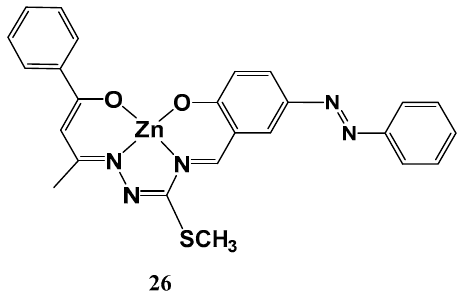
Figure 5. Structure of unsymmetrical Schiff bases of the S ‐ methylisothiosemicarbazide derivative. Unsymmetrical, alkoxy ‐ derivatized Schiff ‐ base Zn(II) complexes, having on one side an alkyl